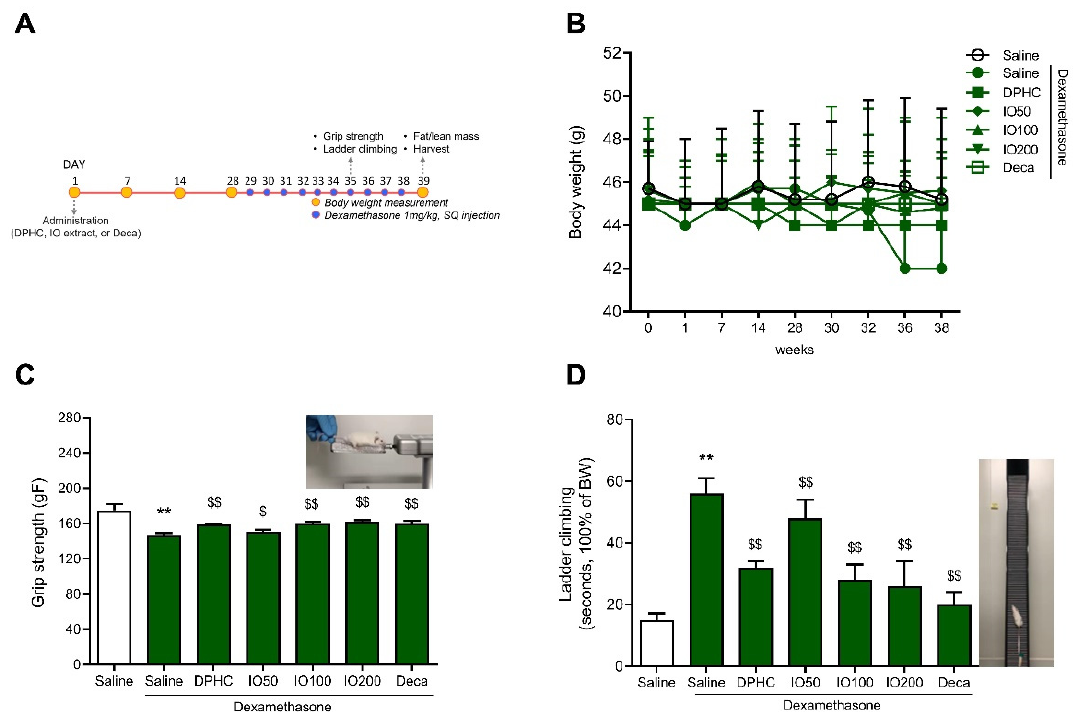
Figure 1. Schematic representation of the in-vivo study design ( A ). Nine-week-old ICR mice were administrated IO extract (50, 100, 200 mg/kg) or DPHC (2.35 mg/kg) daily for 38 days and DEX (1 mg/kg body mass) was injected subcutaneously daily for 10 days. Body weight was determined during the period of administration ( B ). Muscle behavioral responses were assessed using grip strength ( C ) or ladder climbing ( D ) measurements. The captured image for each performance is provided in the upper-right. Each group was examined in n = 7 mice. All values are expressed as the mean ± standard error. Significant differences are indicated as ** p < 0.01 compared with control or $ p < 0.05, $$ p < 0.01 compared with DEX-saline (Mann–Whitney U test).